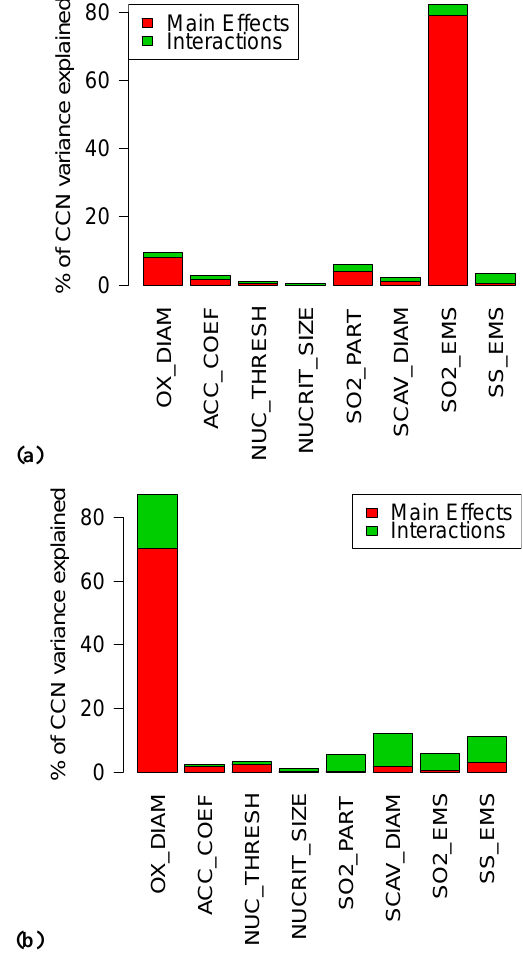
Fig. 7. A bar chart displaying the parameter sensitivities in (a) the polluted grid cell and (b) the remote grid cell. The red bars show the main effect sensitivities and the green bars show how much each pa- rameter interacts with the others to contribute to the CCN